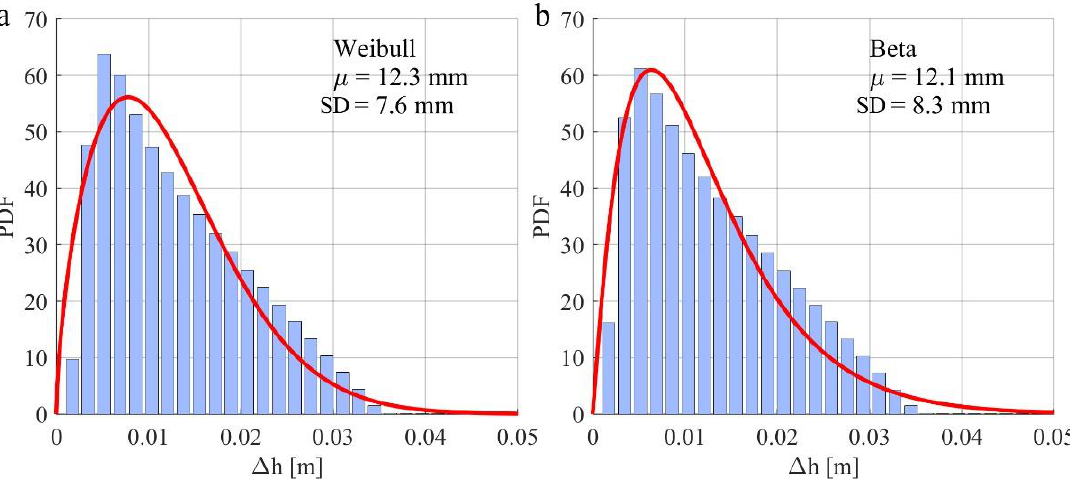
Figure 4. Probability distribution functions that best fit the residues. ( a ) Ordinary kriging; ( b ) inverse distance weighted IDW 2 .